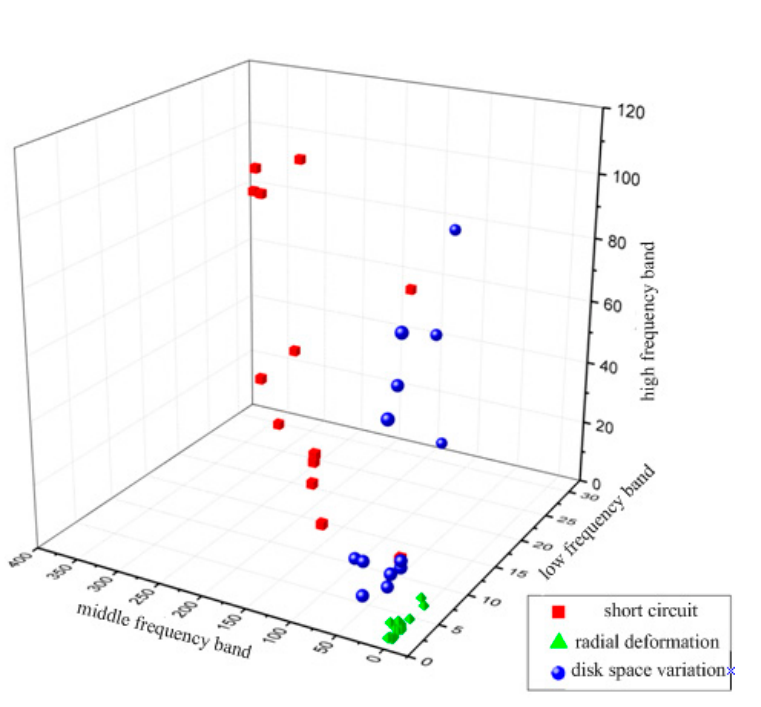
Figure 6. Distribution of mean square error of IFRA signatures under various winding faults.